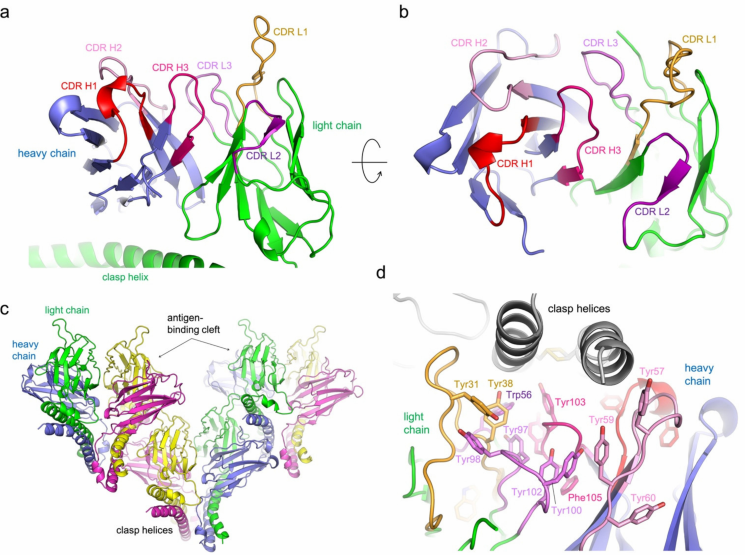
Figure 3. Crystal structure of the 5G7-clasp. ( a ) An overall view of 5G7, with the CDR loops 1–3 of each (heavy and light) chain colored differently. ( b ) Close-up view of the antigen-binding cleft. ( c ) Observed crystal packing showing head-to-tail stacking of 5G7-clasp. ( d ) Binding of the clasp helices in the antigen-binding cleft. The abundance of aromatic side chains of 5G7 is